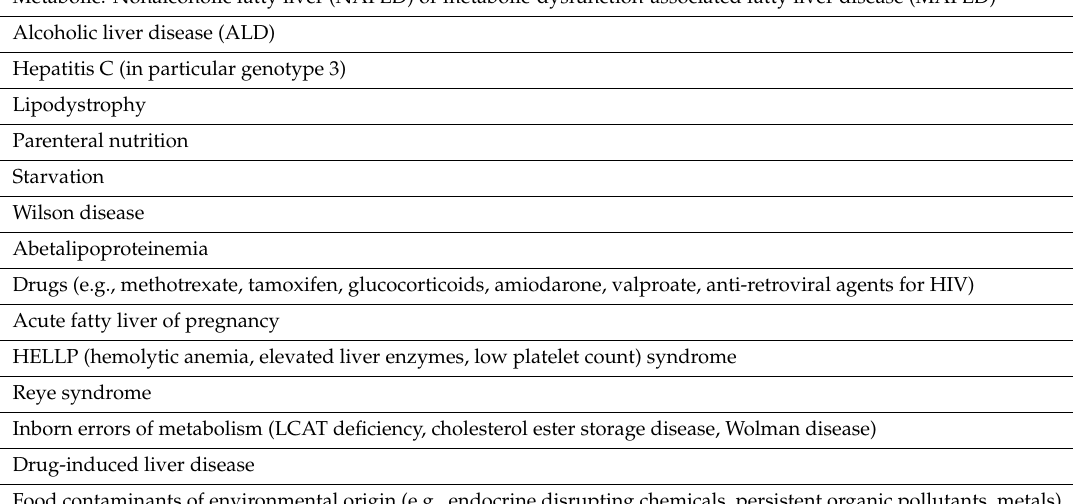
Table 1. Most frequent causes of liver